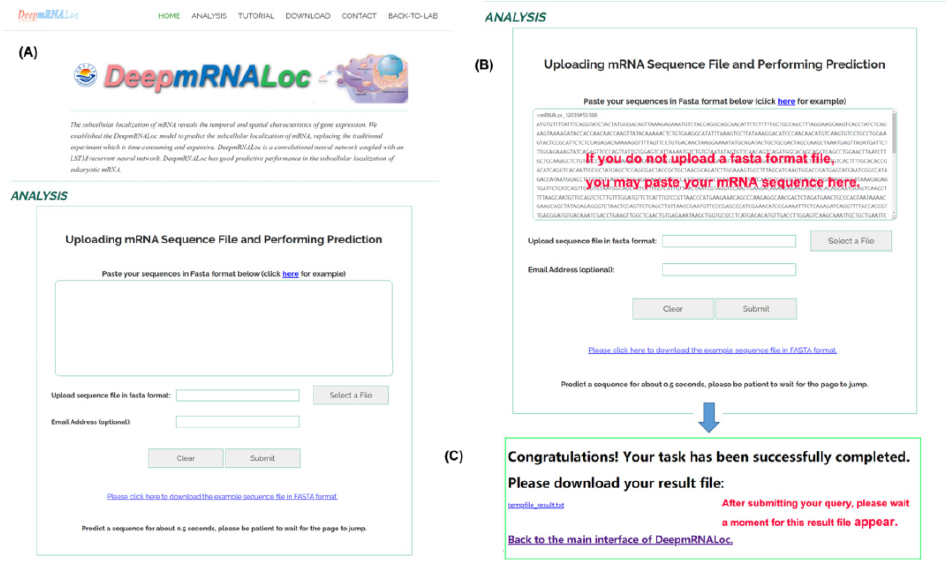
Figure 3. Screenshots of the DeepmRNALoc web server. ( A ) The web interface; ( B ) input data upload and information-filling interface; and ( C ) result download page.